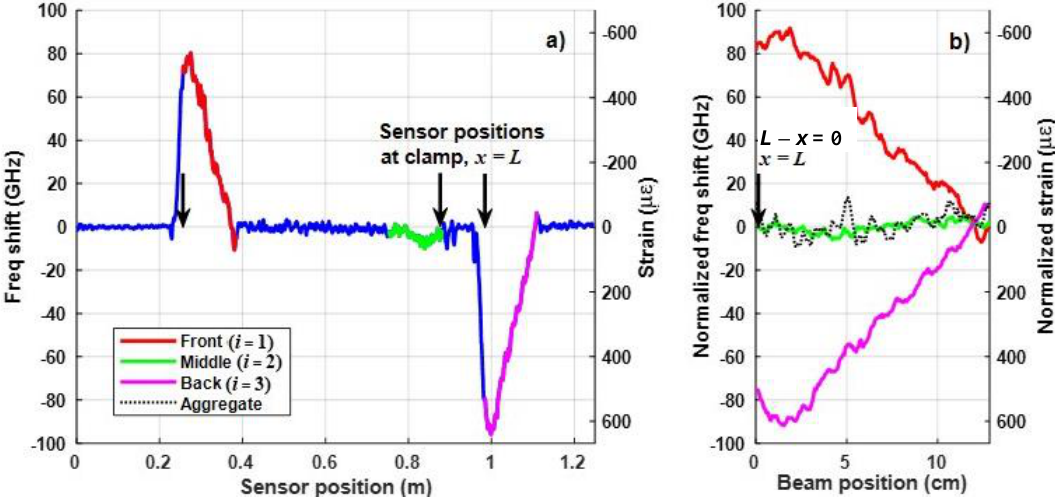
(cid:10) (cid:11) (cid:10) ε ( (cid:11) f s t (left axis) and strain ( , ) s t  (right axis) vs. f ( s , t ) s , t ) (left axis) and strain t t t (right axis) vs. sensor t (cid:16) (cid:17) f iss ( L − x , y i ) − f S i 2 ss (black dotted line) vs. the beam position